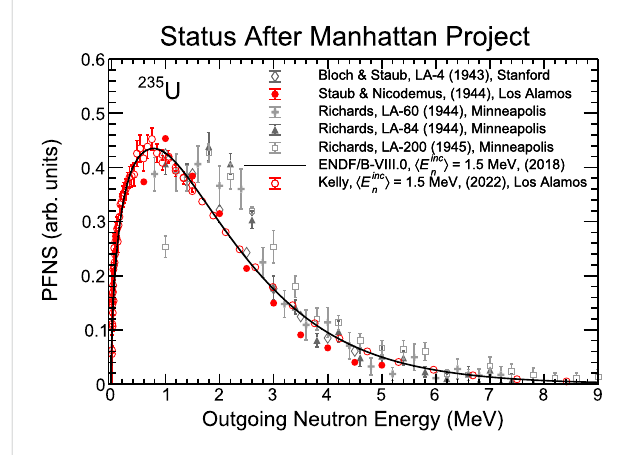
Status of 235 U PFNS measurements by the end of the Manhattan